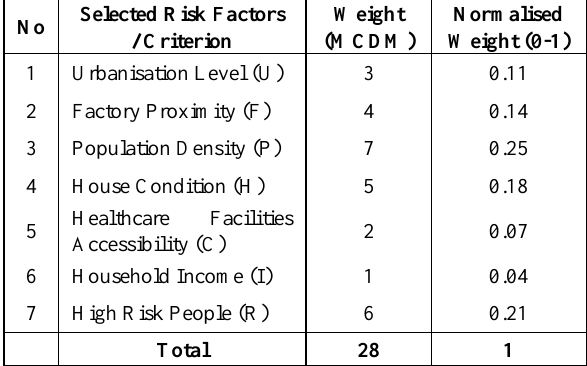
Table 1. Tuberculosis risk factors and weights at Section U19